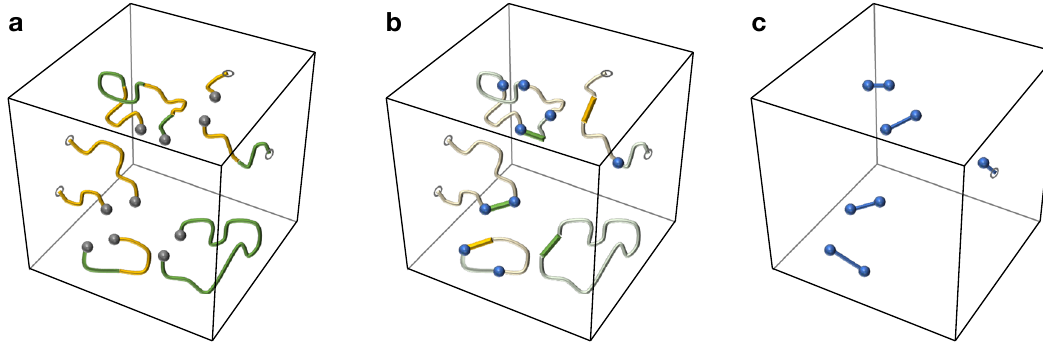
ζ + b μ Þ =0.Then,wecomputeasyndrome ζ + b μ hastrivialrelationsyndrome,i.e., δ R ð